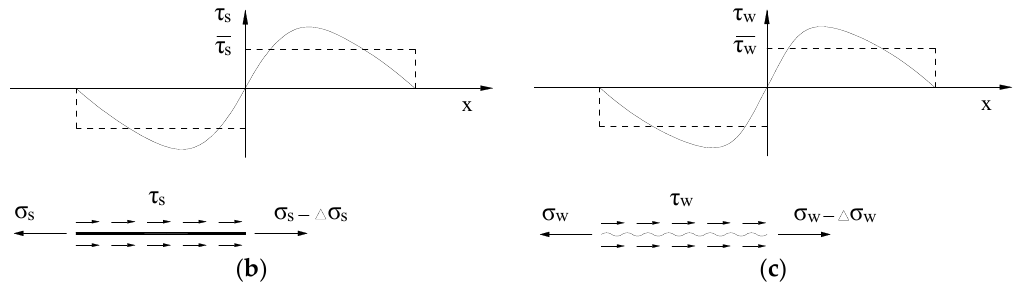
Figure 10. Analysis of crack distribution: ( a ) Segmental model, ( b ) bonding stress distribution between steel bar and concrete, ( c ) bonding stress distribution between steel wire and resin concrete. Equations (1) and (2) can be obtained according to the force equilibrium of the segmental model